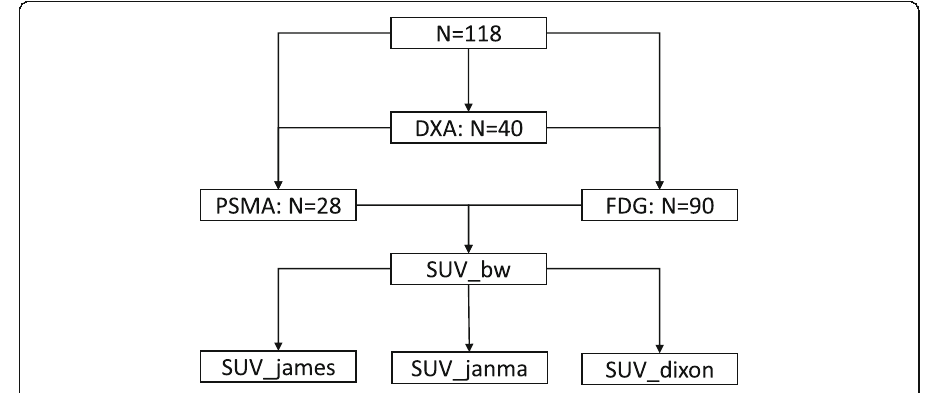
Fig. 1 A flow chart of study design and patient enrollment